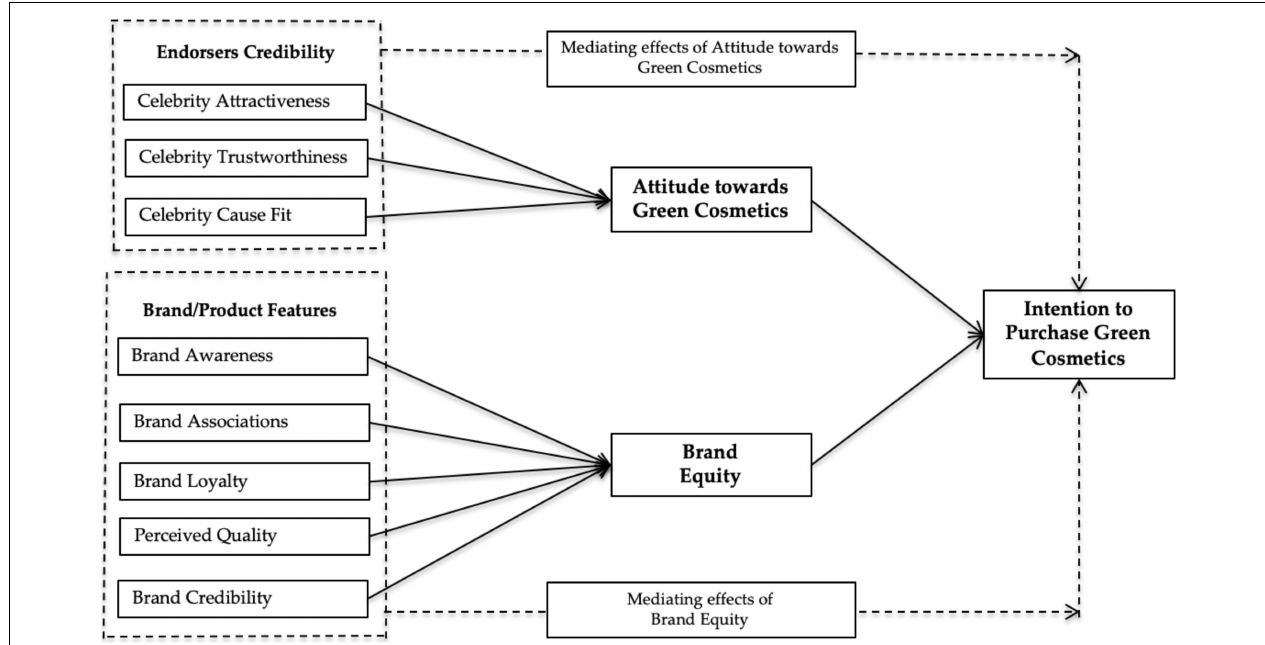
FIGURE 1 | Research